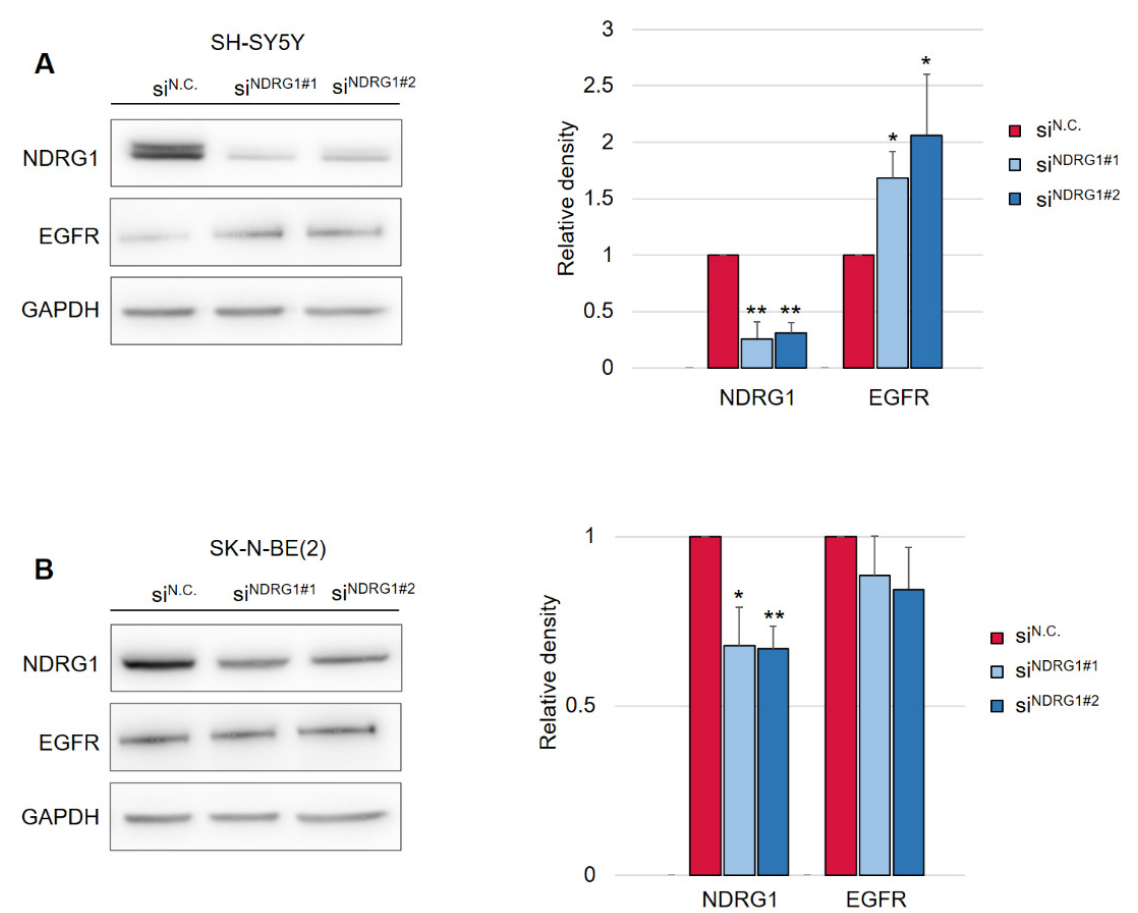
Figure 3. Silencing of NDRG1 rescues the effect of DpC on total levels of EGFR in the SH-SY5Y cell line but not in SK-N-BE(2). ( A ) Immunoblotting of NDRG1 and EGFR protein levels in SH-SY5Y cells treated with 20 µ M DpC for 48 h and specific siRNAs for NDRG1 (siNDRG1#1 and siNDRG1#2) or negative silencer control (siN.C.). ( B ) Immunoblotting of NDRG1 and EGFR protein levels in SK-N-BE(2) cells treated with 20 µ M DpC for 48 h and specific siRNAs for NDRG1 (siNDRG1#1 and siNDRG1#2) or negative silencer control (siN.C.). Representative images ( left ) and relative optical density values ( right ) of three independent experiments. Densitometry data are shown as the mean ± SD normalized to siN.C. values. * p < 0.05; ** p < 0.01; two-tailed unpaired t -test.